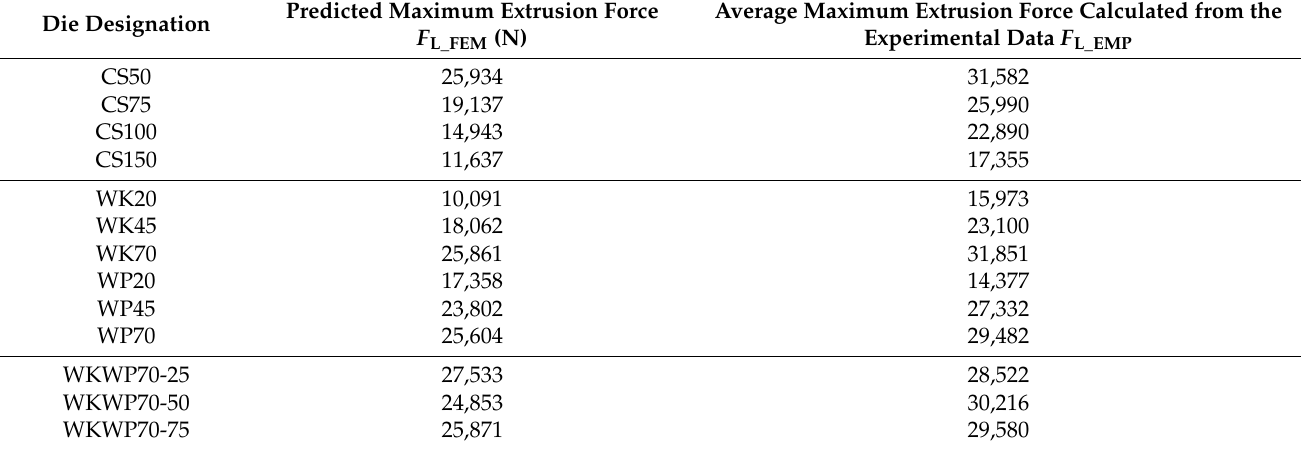
Table 9. Maximum predicted extrusion force F L_FEM and its average value calculated from the experimental data F L_EMP